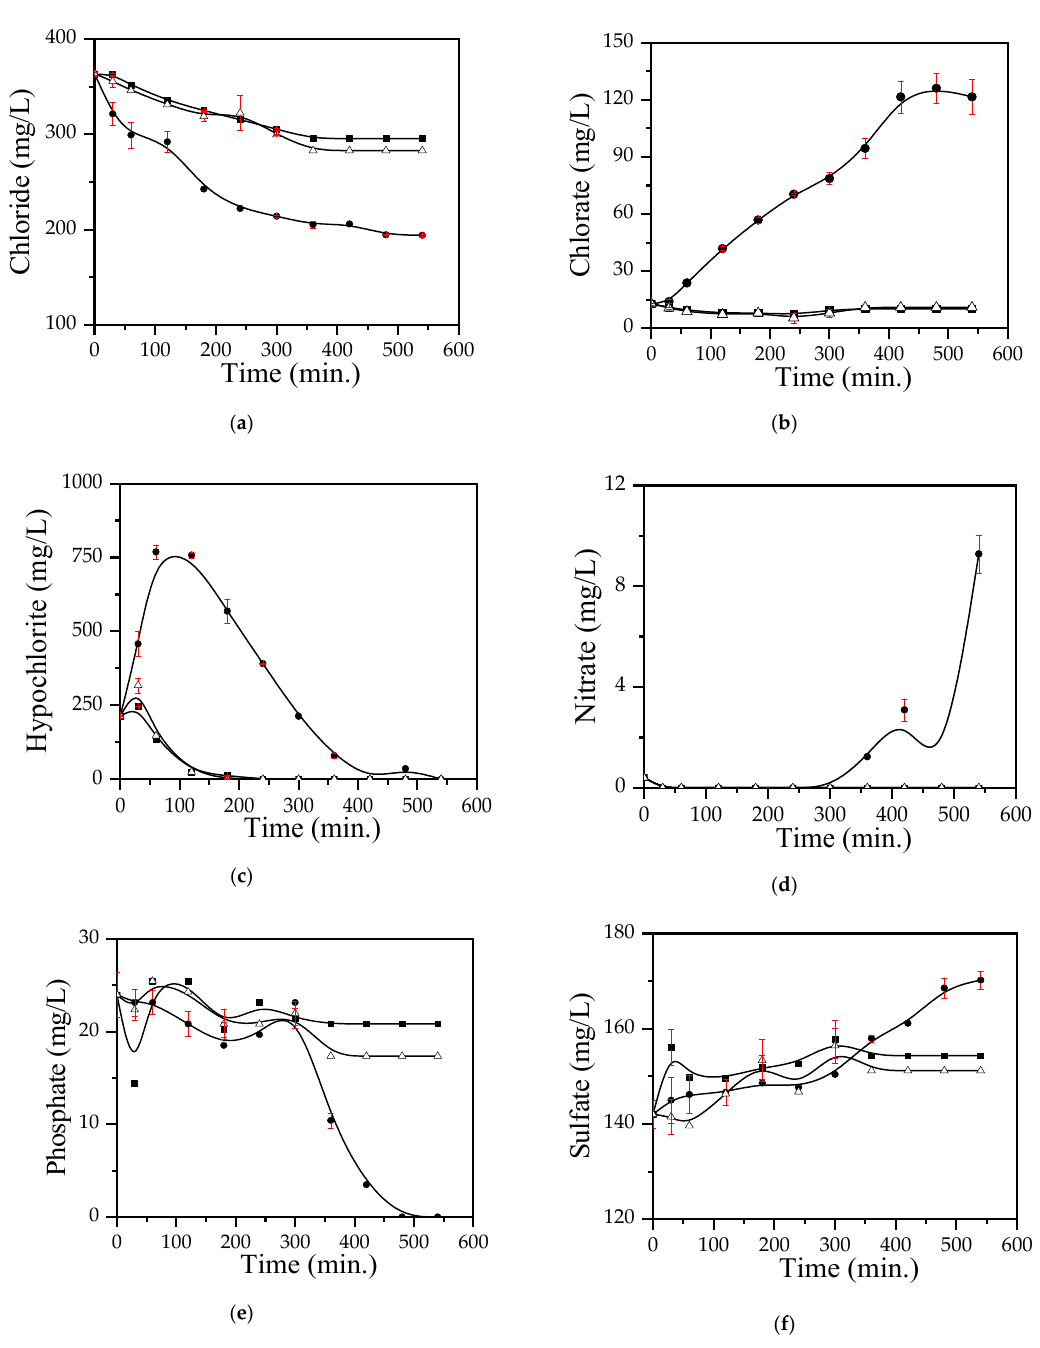
Figure 7. Monitoring of ion concentration during each electrolysis without the addition of electrolyte support at 25 °C and pH 4.28 applying 30 mA/cm 2 . ( a ) Chloride, ( b ) Chlorate, ( c ) Hypochlorite, ( d ) Nitrate, ( e ) Phosphate, ( f ) Sulfate. ( ■ ) MMO-Cl 2 , ( ∆ ) MMO-O 2 , ( ● ) BDD. Samples tested: 11.